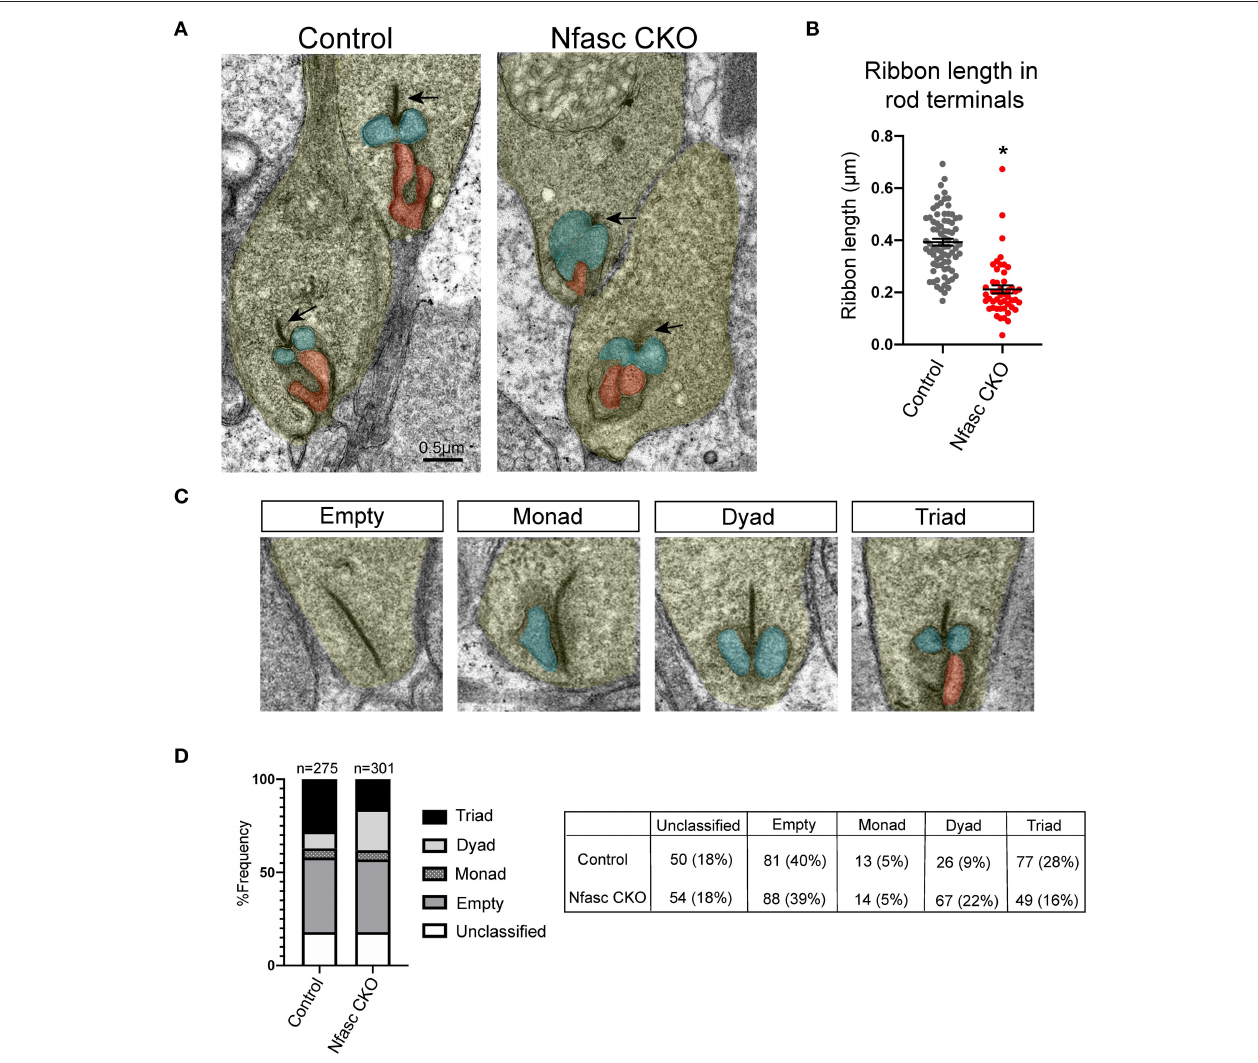
FIGURE 4 | Transmission Electron Microscopic (TEM) analysis reveals synaptic defects in Nfasc CKO (A–D). Representative electron micrographs of rod terminals of controls and Nfasc CKO mice at P30 (A) . In controls, rod terminals (yellow) contain large, well-defined ribbon synapses (arrows) with invaginations from horizontal cells (blue) and ON bipolar cells (red). In contrast, Nfasc CKO display short and poorly defined ribbon synapses (arrows). Quantification of the length of ribbon synapses in controls (77 rod terminals; n = 4 mice) and Nfasc CKO (49 rod terminals; n = 4 mice). Data represented as mean ± SEM. Statistical significance determined by an unpaired t -test. * p < 0.0001 (B) . Rod terminals were designated as unclassified, empty, monad, dyad, or triad (C) . A total of 275 rod terminals were analyzed for controls ( n = 4 mice) and 301 rod terminals for Nfasc CKO ( n = 4 mice). Frequency (%) shown for controls and Nfasc CKO in (D) . Exact values are listed in the table. Scale bar = 0.5 µ